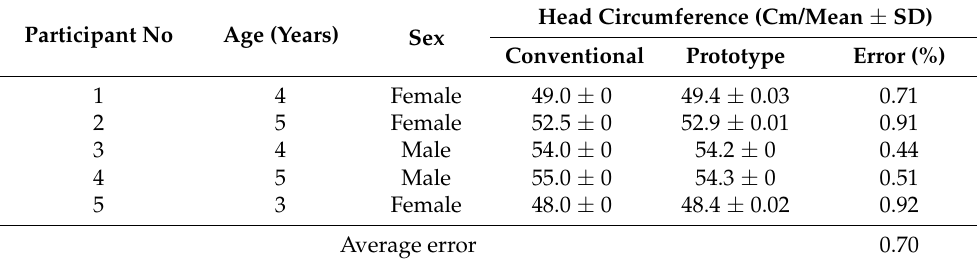
Table 4. Comparison between head circumference measurement results using conventional tools (measuring tape) and a prototype (IR sensor).